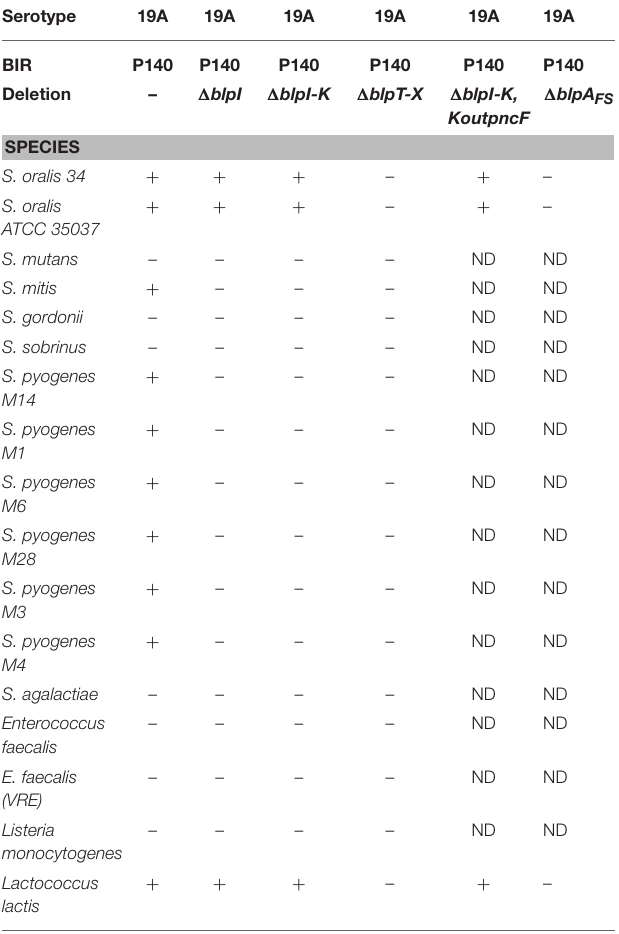
blpJ together ( P < 0.0001 difference between observed